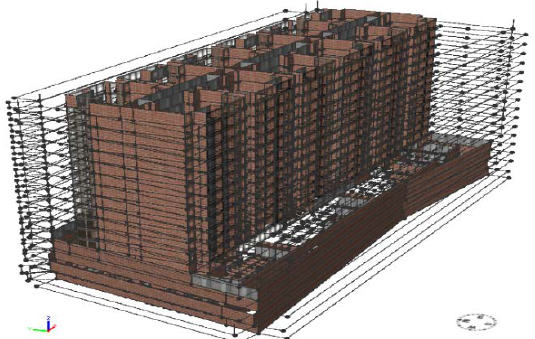
Figure 4. The 3D building model rendered in CityEngine